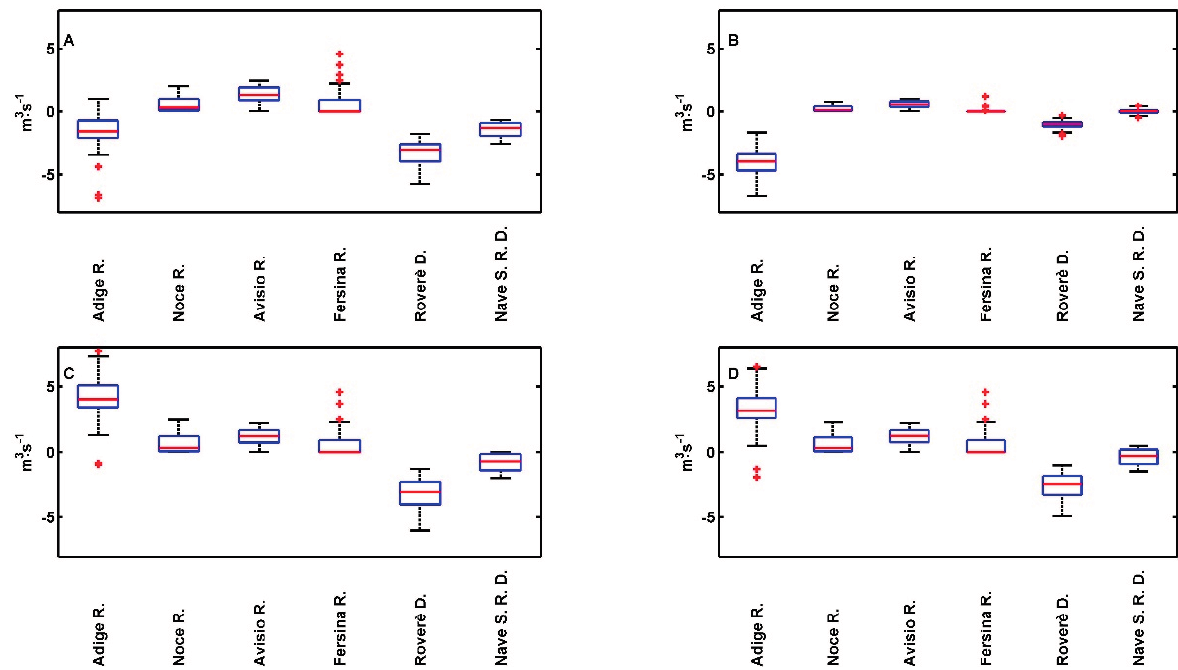
Figure 10. Box plots of the exchange fluxes between surface water bodies and the aquifer for the Base Scenario ( A ); the Scenario RS05 ( B ); the Scenario PW5A ( C ) and the Scenario PW5B ( D ), computed by using 25 Monte Carlos